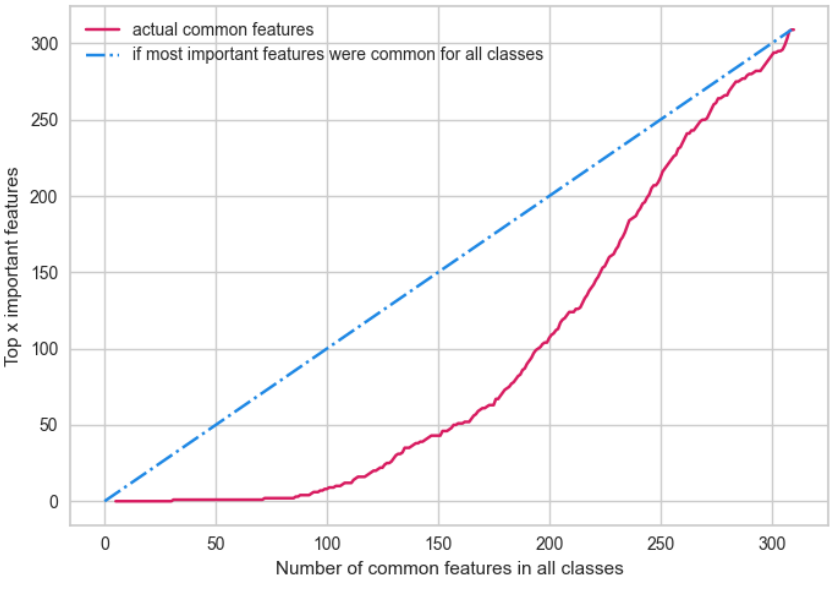
Figure 8. The union of the 25 most important features per bot type is equal to zero. Common, for all classes, important features make their appearance after the first 25 most important ones.